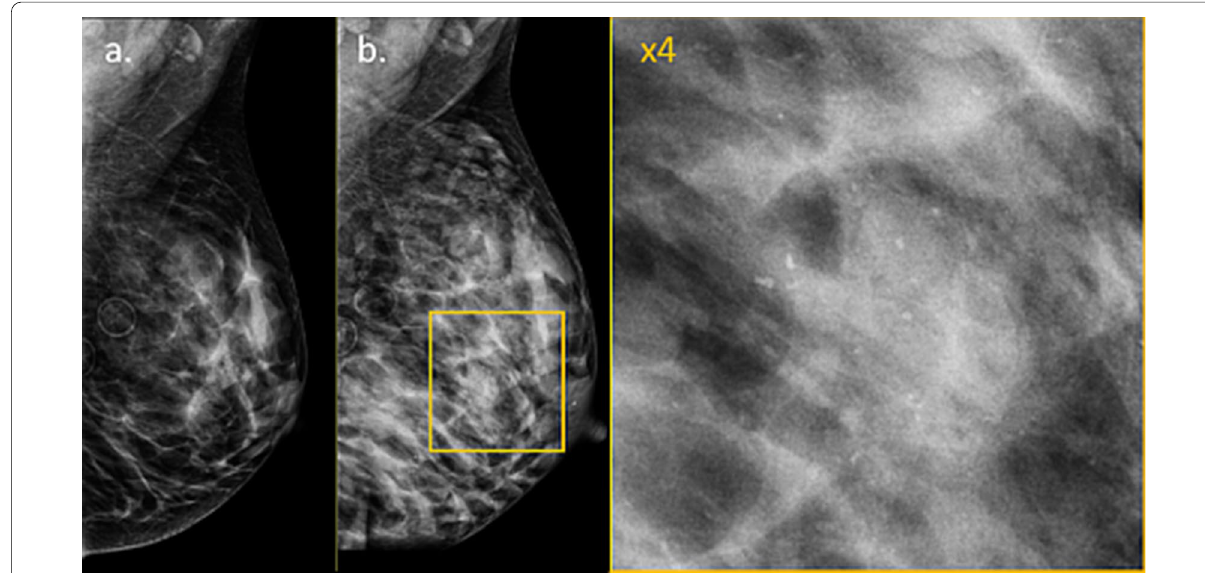
Fig. 1 Changes in mammographic density and lactation‑associated microcalcifications. Left breast medio‑lateral‑oblique view mammograms of the same patients, performed 2 years apart, prior to pregnancy ( a ) and during lactation ( b ) are presented, demonstrating the marked increase in breast volume and mammographic density associated with pregnancy and lactation. Additionally, new onset of lactation‑associated microcalcifications was depicted globally on both breasts ( b and zoomed